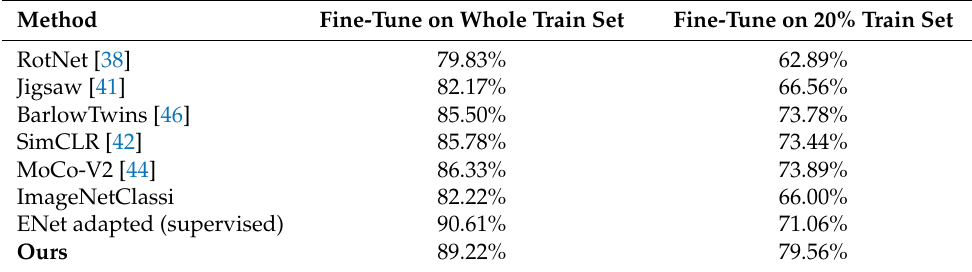
Table 6. Test accuracy of different methods under the fine-tuning evaluation protocol for the 5-class classification problem of CG forensics (the 5 classes being NI, CG of Artlantis, CG of Autodesk, CG of Corona, and CG of VRay). The presented results are classification accuracies on the testing set of a dataset properly constructed from the four datasets of Artlantis, Autodesk, Corona and VRay ( cf. the last paragraph of Section 4.3 for details). The pretext task training of all self-supervised methods and the training of the ImageNetClassi method were carried out on the whole ImageNet